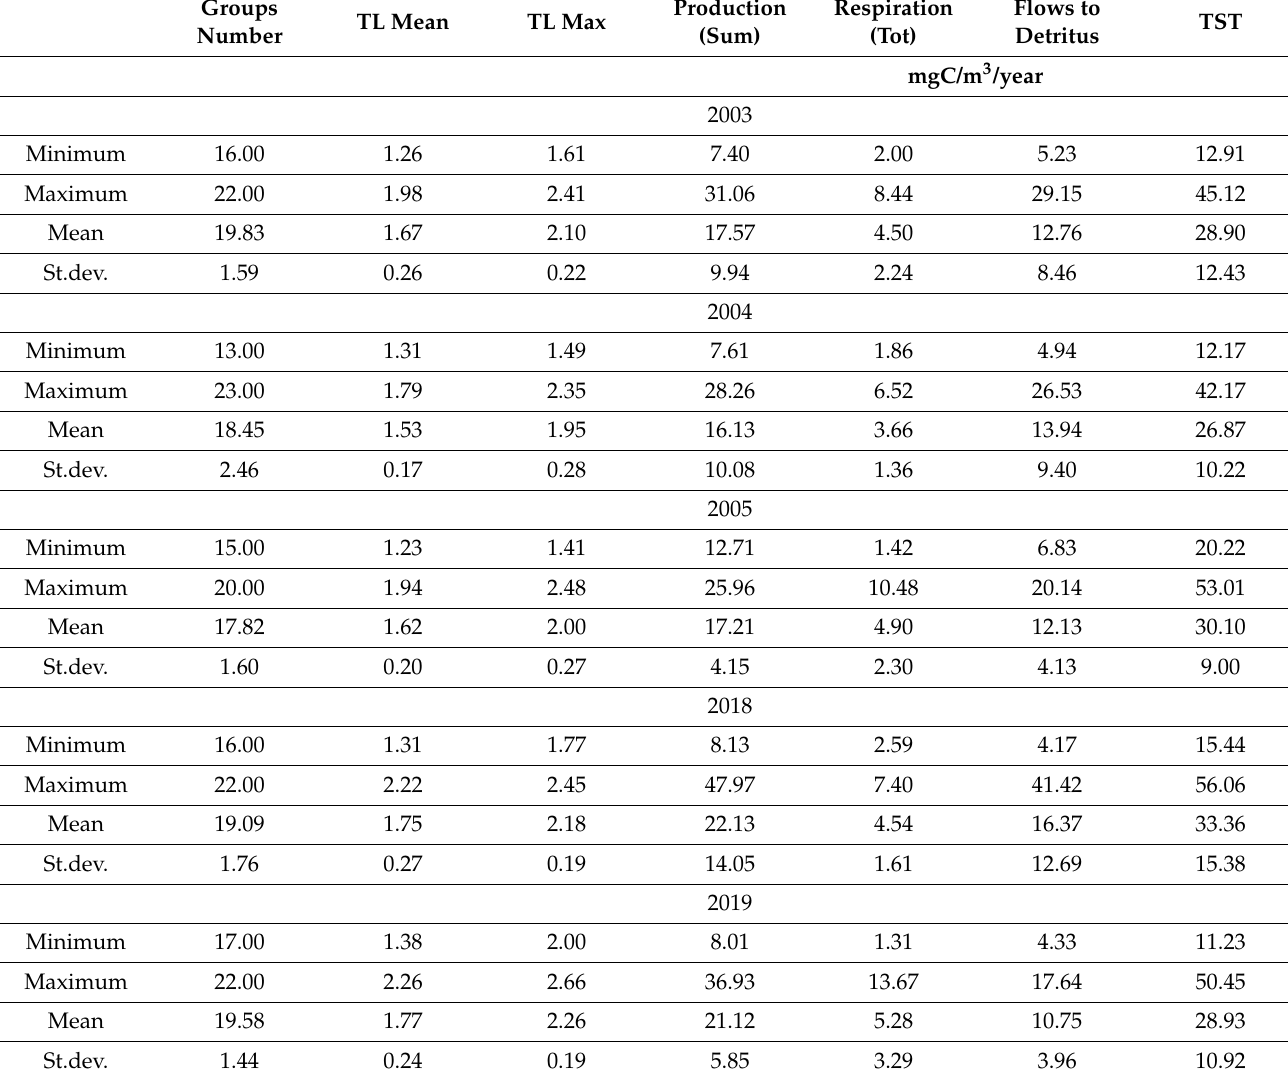
Table 1. Output parameters from the Punta Faro mesozooplankton community model (TL: trophic level, TST: total system